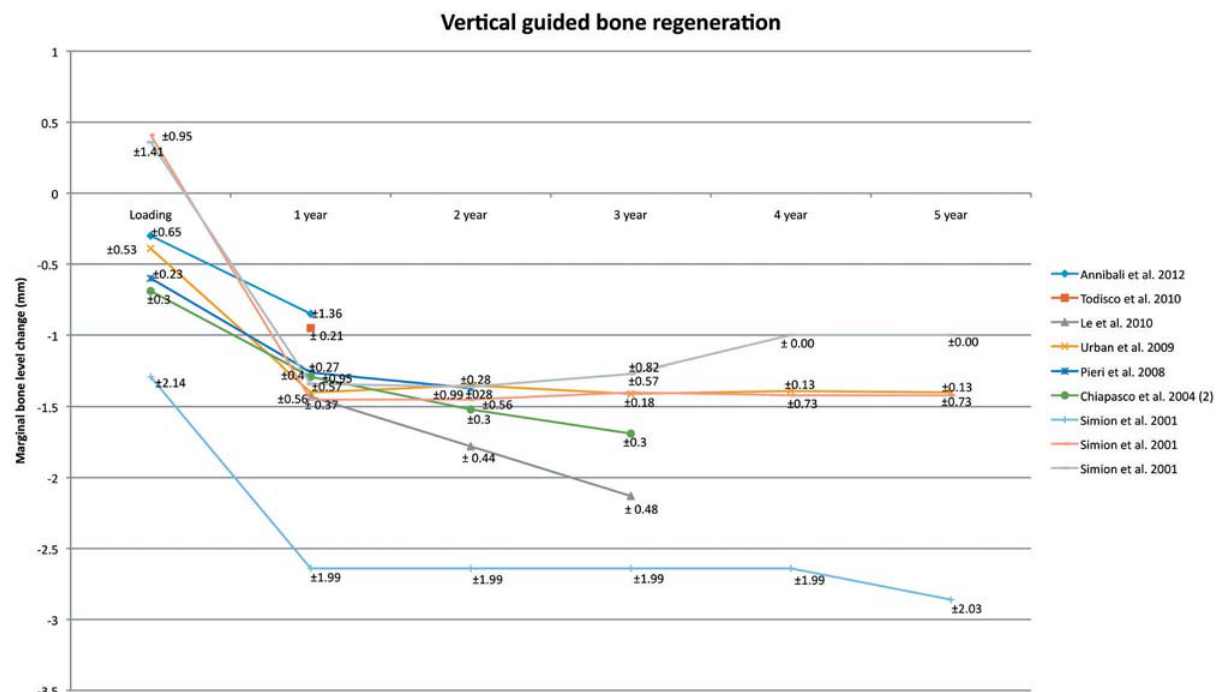
Figure 6- Vertical guided bone regeneration. Mean and Standard Deviation are